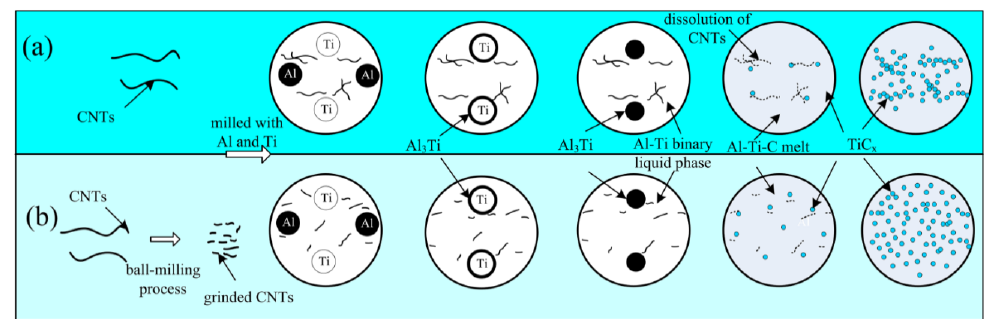
Figure 7. The proposed reaction mechanism of the combustion reaction by using ( a ) untreated CNTs; ( b ) ground CNTs as carbon source in the 2009Al ‐ Ti ‐ CNTs system.